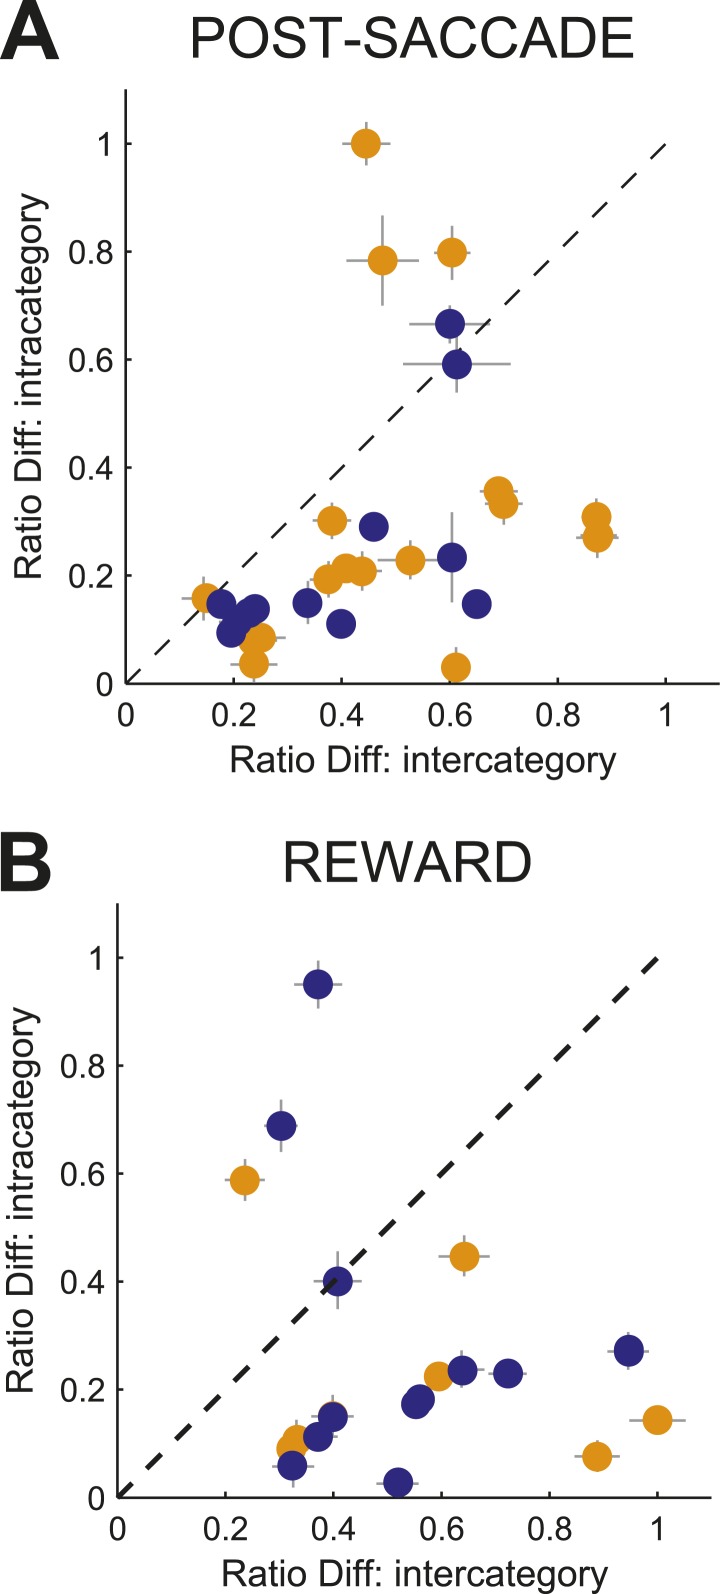
Effect of categorical perception on discrimination of near boundary stimuli in individual neurons.Ratio Difference indexes for each neuron with activity during post-saccade (A) and reward (B) periods showing difference in neuronal activity between speed pairs (4/6 or 12/14) when categorized as same (Ratio Diff: intracategory) or different (Ratio Diff: intercategory) categories. For each neuron, a pair (4/6 or 12/14) with the maximum Ratio Diff is plotted for each period of the task. Orange/blue indicates the maximum Ratio Diff for pairs 4/6 or 12/14, respectively.